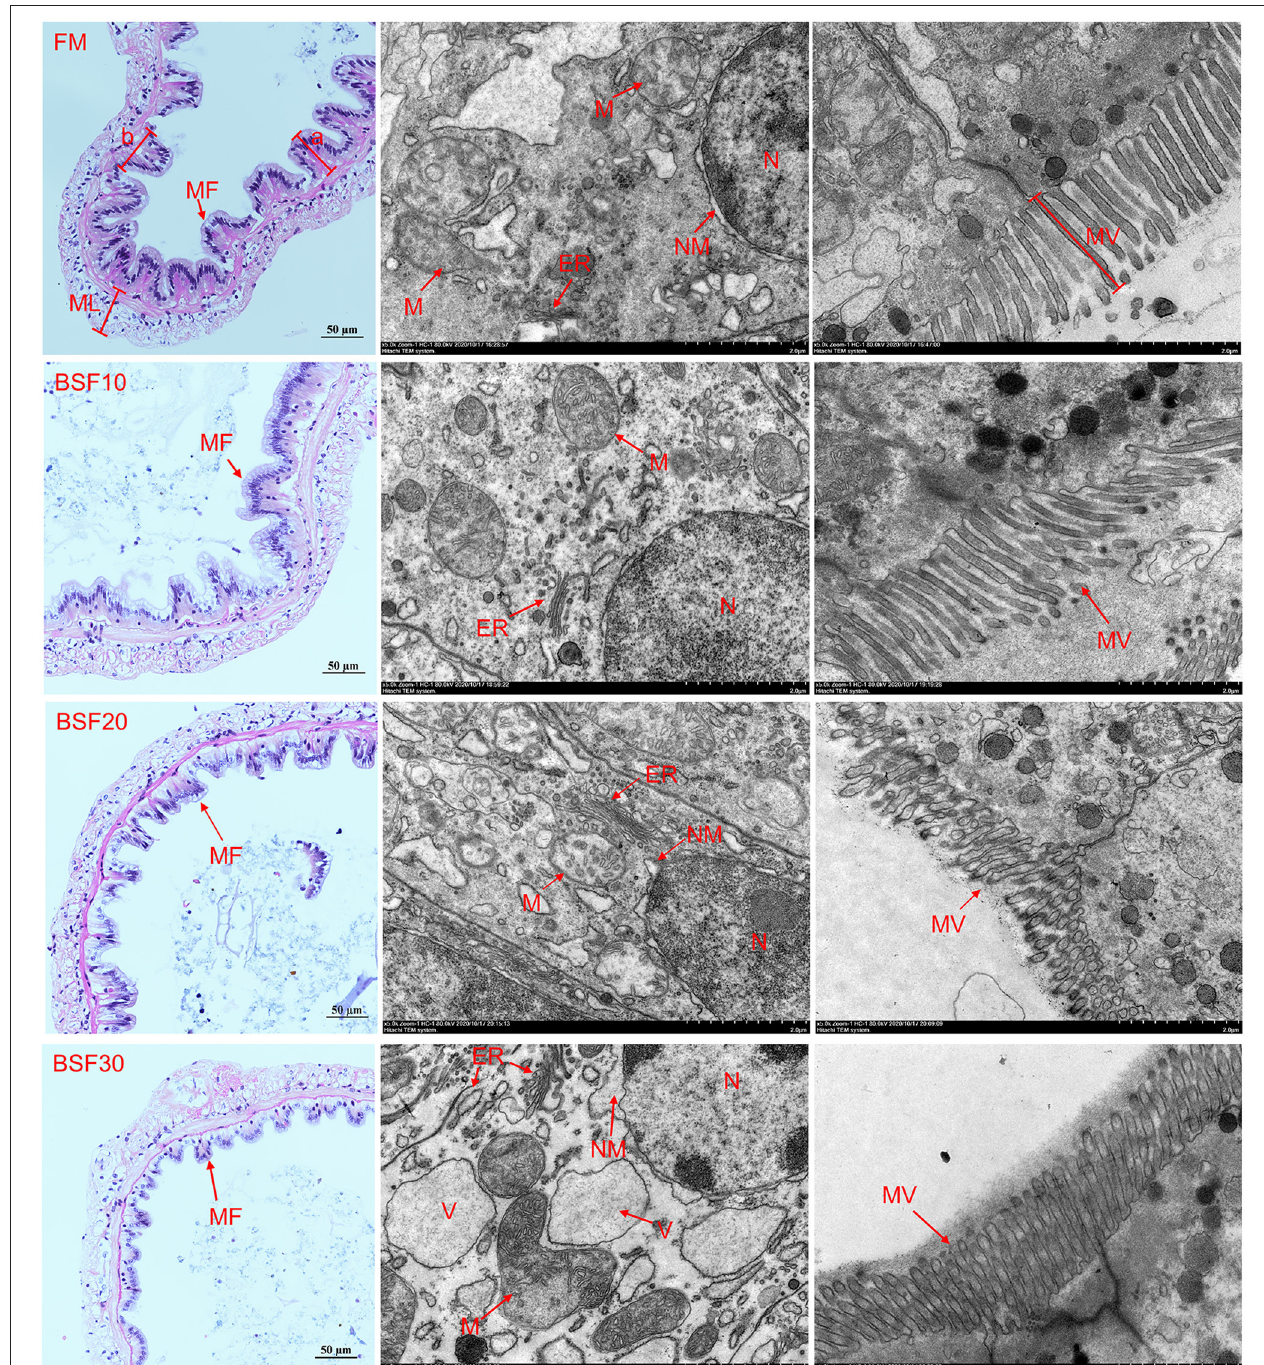
FIGURE 2 | Effect of BSF on midgut histology of L. vannamei . Where: ER, endoplasmic reticulum; N, cell nucleus; NM, nucleus membrane; MF, mucosal folds; ML, muscle layer; M, mitochondria; MV, microvilli; V, Vesicles. a shows height of mucosal folds; and b shows width of mucosal folds. Pictures in the same row are considered as the same